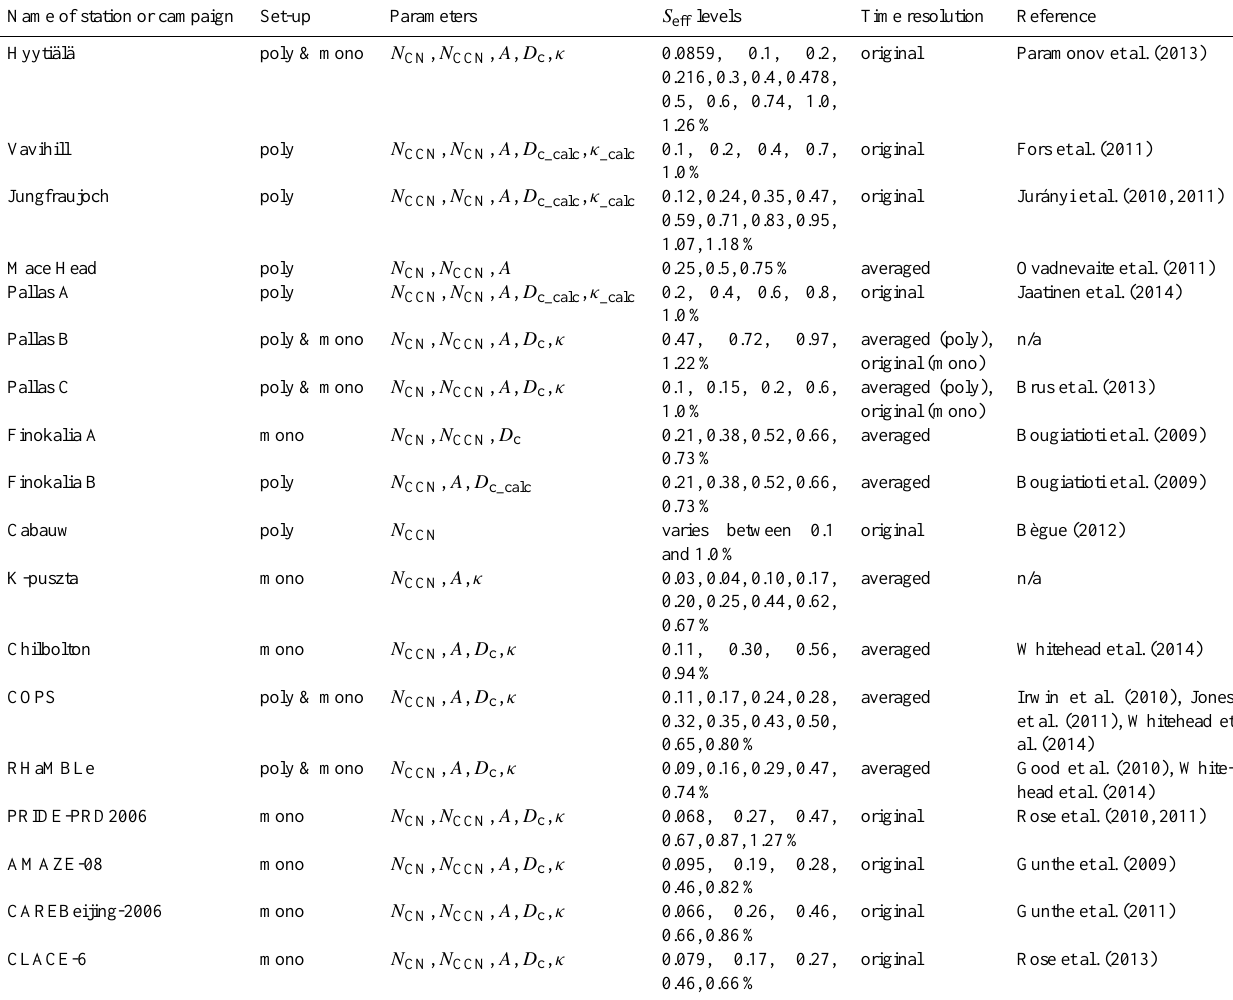
Table 2. Summary of available data for each measurement location. N CCN is the CCN number concentration, N CN is the total number concentration, A is the activated fraction, D c is the critical dry diameter and κ is the hygroscopicity parameter. The “set-up” column indicates whether the CCNC was operating in polydisperse or monodisperse mode. D c_calc and κ _calc have been calculated from polydisperse data using the differential/scanning mobility particle sizer (DMPS/SMPS)